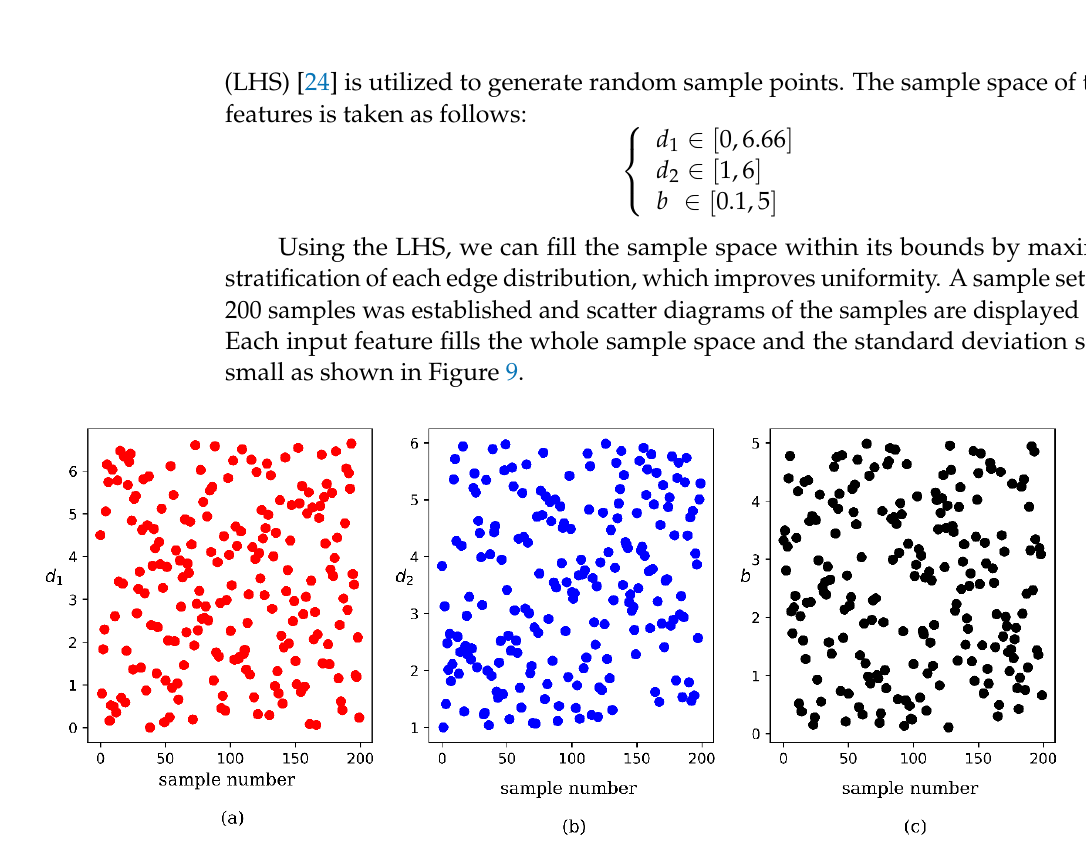
Figure 9. Scatter diagrams of the samples of input feature: ( a ) barrier height, ( b ) submergence depth of a chamber wall, and ( c ) barrier distance.